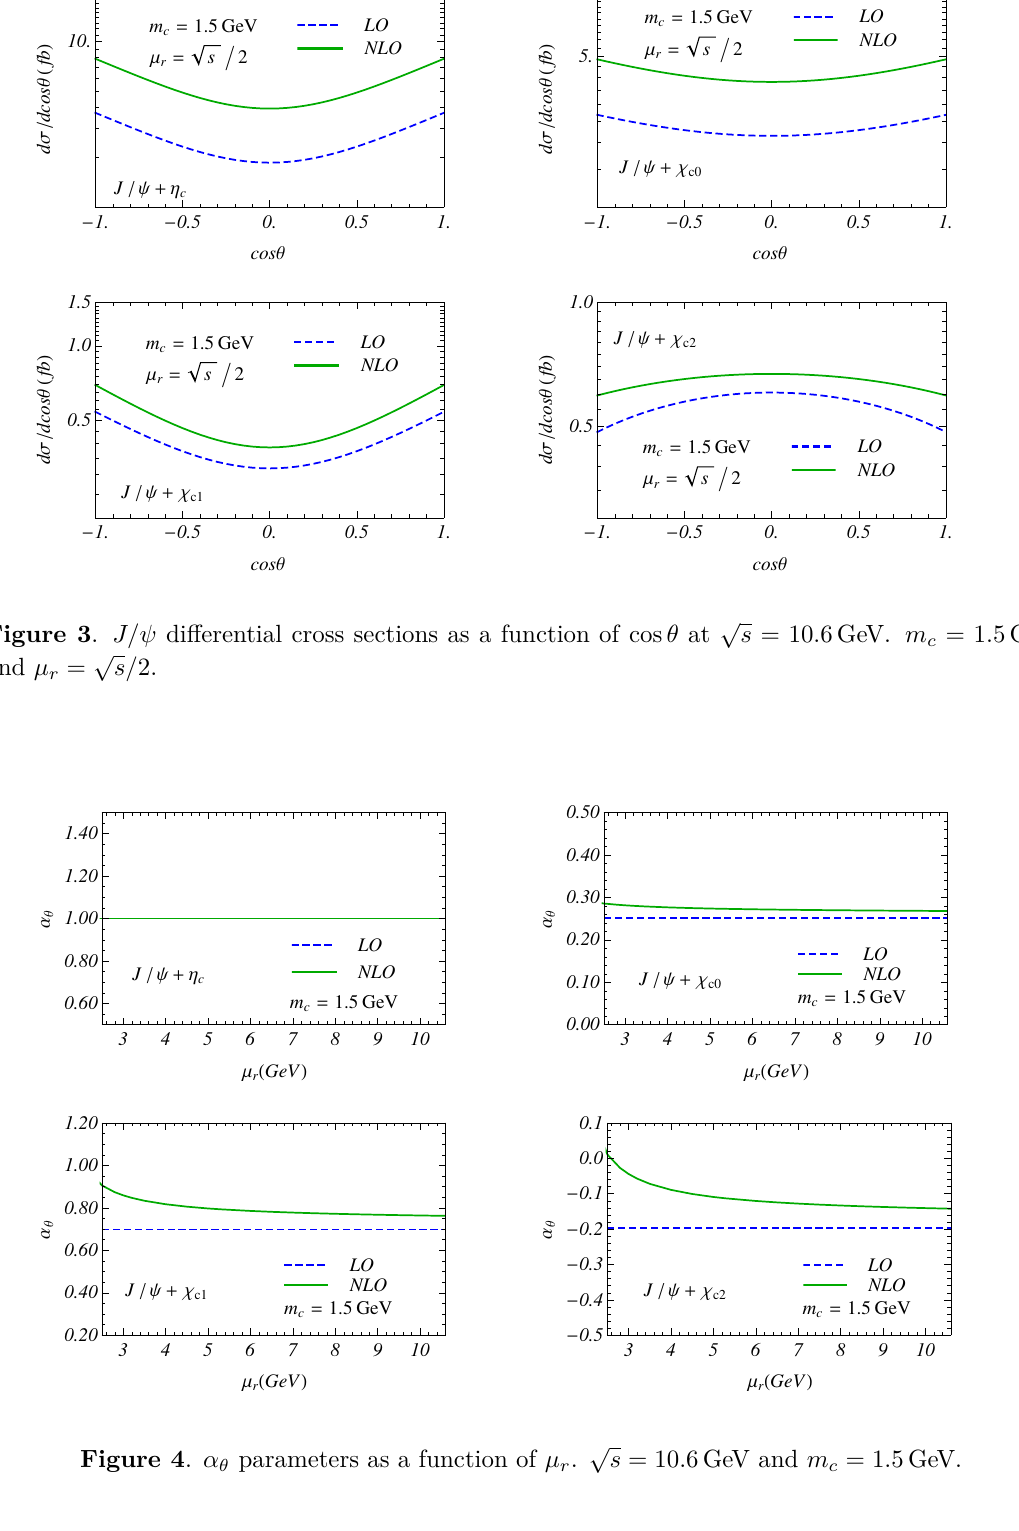
Figure 4 . α θ parameters as a function of µ r .